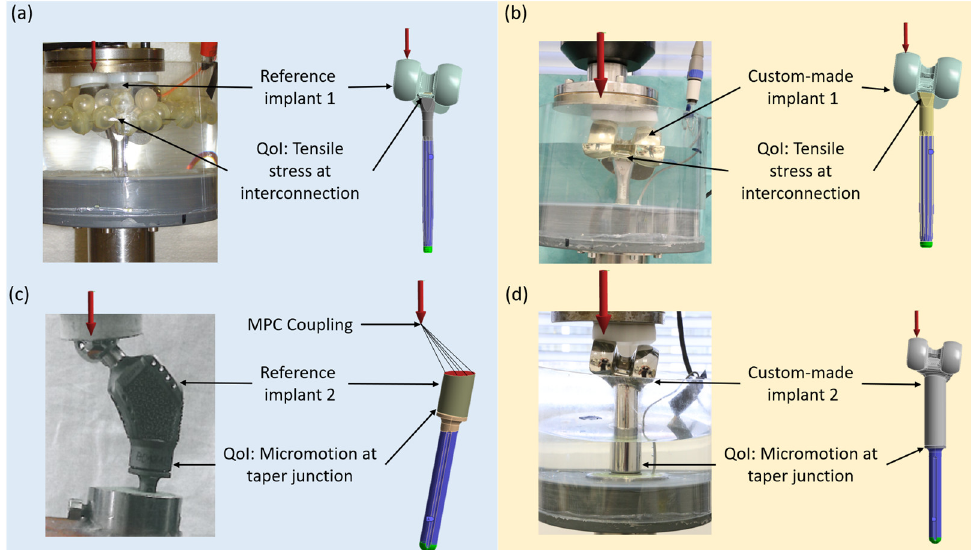
Figure 3. Biomechanical test and finite element analysis setup of ( a ) reference implant 1, ( b ) custom- made implant 1, ( c ) reference implant 2, and ( d ) custom-made implant 2. Multi-point constraint (MPC), Quantity of interest